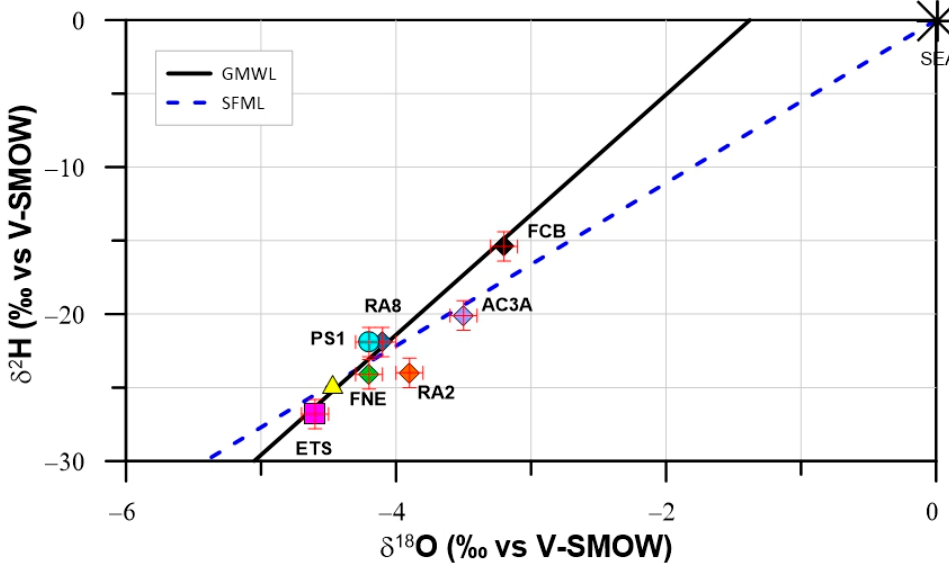
Figure 5. δ 2 H- δ 18 O scatter diagram of sampled waters. Yellow triangle: shallow groundwater system of Sintra Massif, from [55]; GMWL: Global Meteoric Water Line [21]; SFML: Seawater—Freshwater Mixing Line.